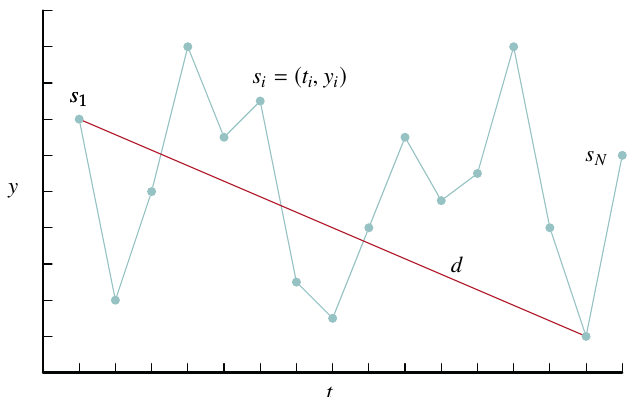
b ∈ R M Figure 3: Original EPS image